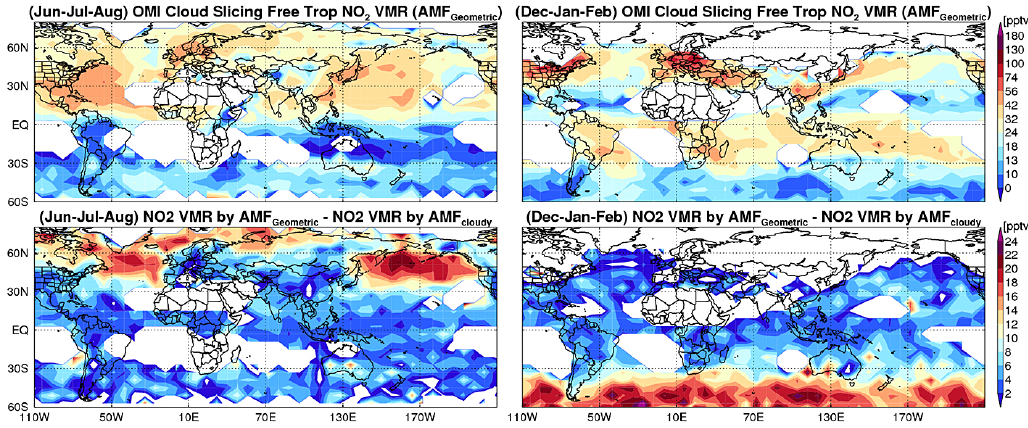
Figure D2. For June–August (left) and December–February (right) averaged over 2005–2007, top: global maps of NO 2 VMR calculated using geometric AMFs; bottom: difference in NO 2 VMRs computed using geometric and near-Lambertian AMFs.